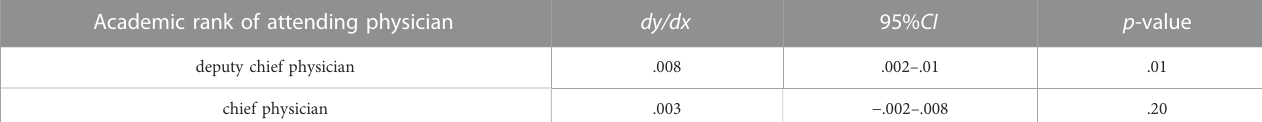
TABLE 4 Fixing the academic rank of the attending physician, the marginal effects of patient ’ s age on biosimilar uptake.